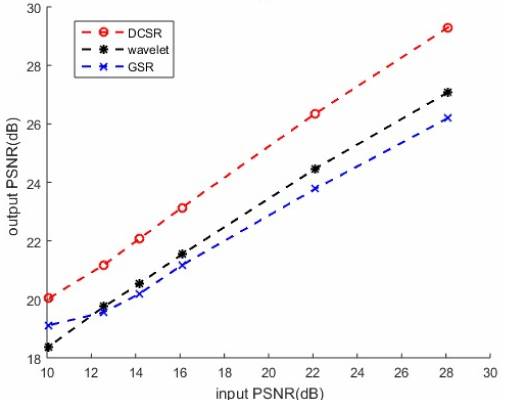
Figure 8. Color image corrupted by AWGN: performance analysis of three denoising methods.